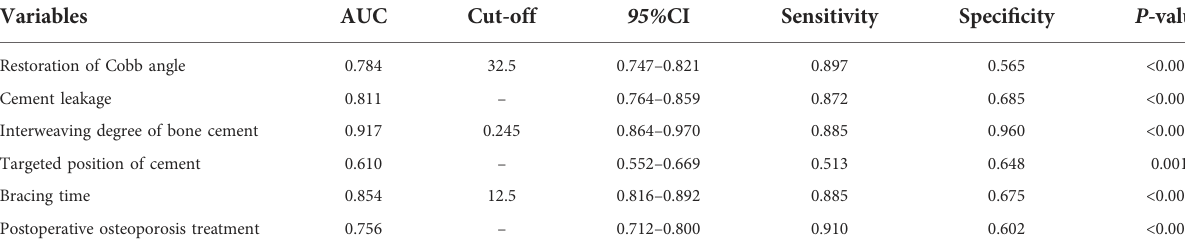
TABLE 3 Predictive performance of related indexes on bone cement